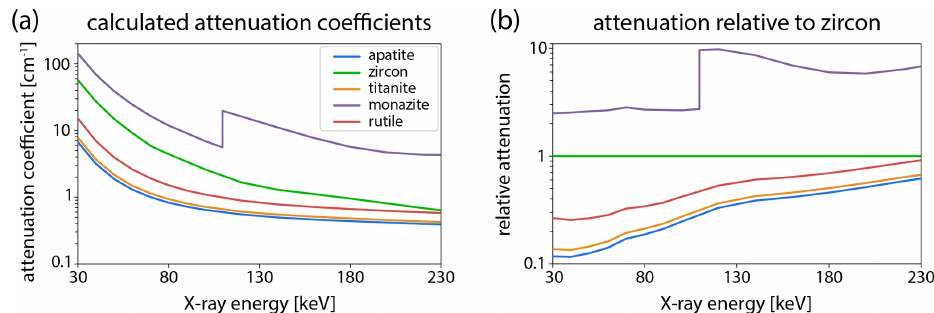
Figure 3. (a) Attenuation coefficients for commonly dated minerals over a range of X-ray energies calculated with MuCalc. (b) The same modeled attenuation coefficient data normalized by zircon. Generally, higher attenuation coefficients mean brighter grayscale values in reconstructed microCT data. A greater difference in attenuation coefficients between mineral phases aids in mineral identification.